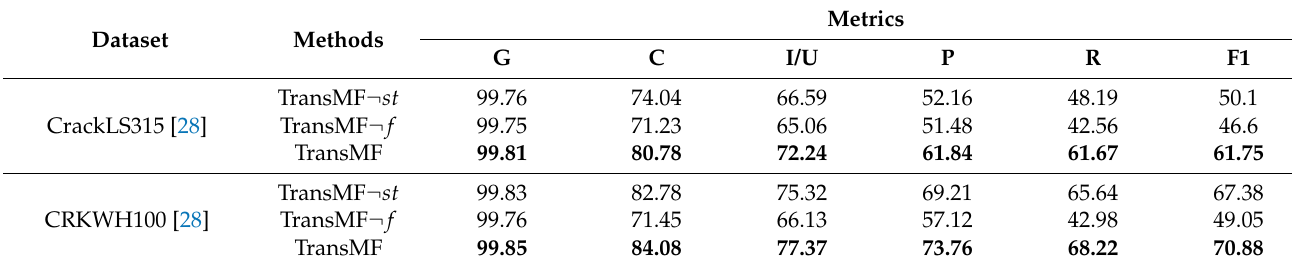
Table 4. The results of comparison among different variants of TransMF on CrackLS315 and CRKWH100 datasets. The bold means that the best result.